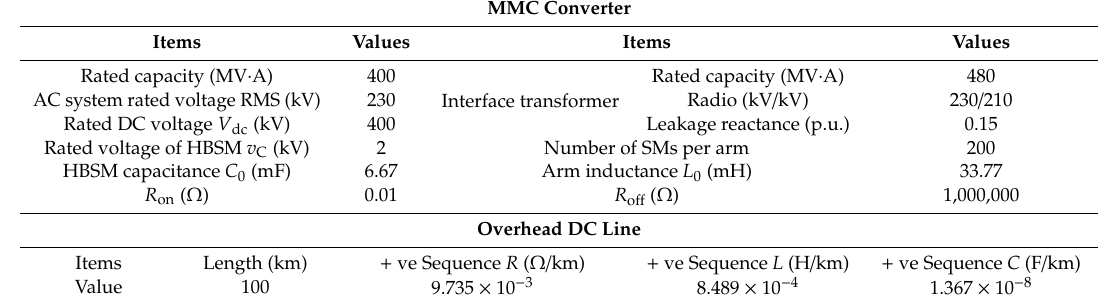
Figure 9. The two-terminal monopolar MMC-HVDC system.